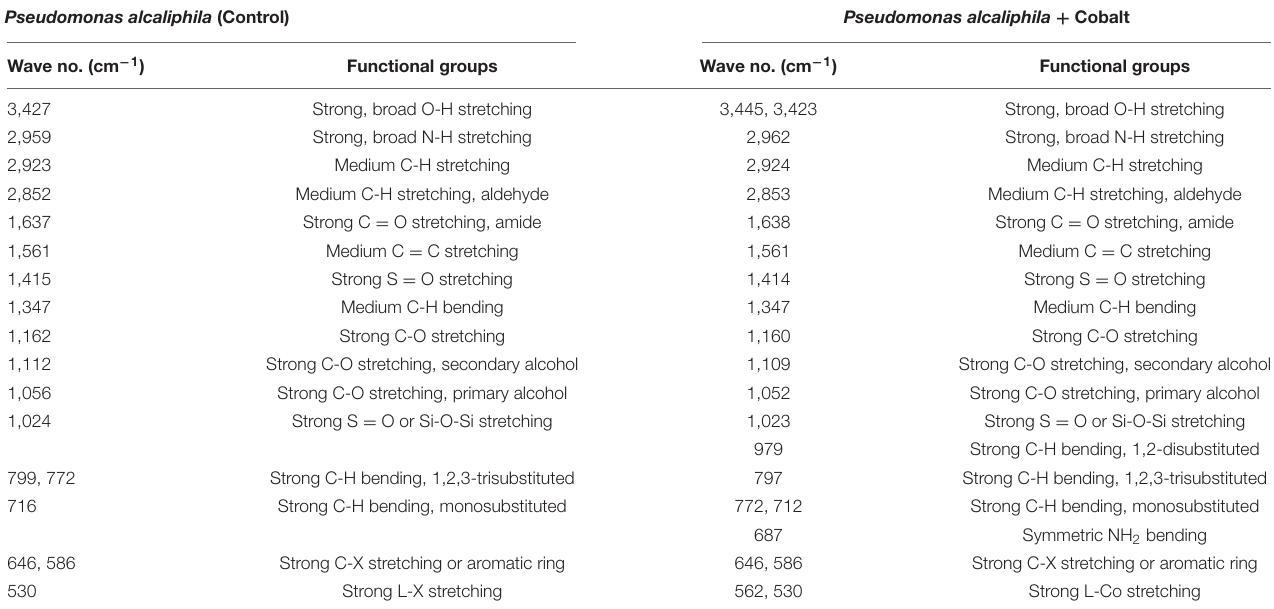
TABLE 4 | Fourier transform infrared spectroscopy (FTIR) spectral analysis for P . alcaliphila NEWG-2 before and after biosorption of Co (II) ions. Pseudomonas alcaliphila (Control) Pseudomonas alcaliphila + Cobalt Wave no. (cm − 1